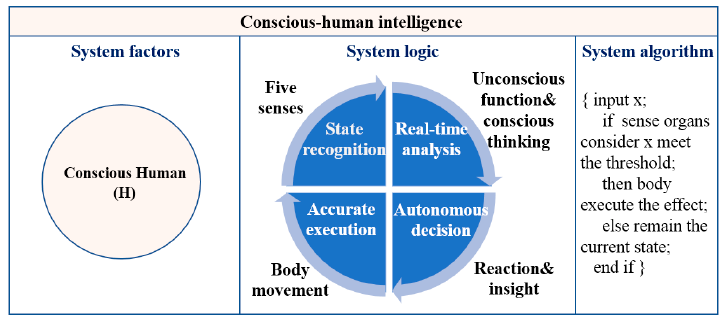
Figure 4. Human intelligence (Type